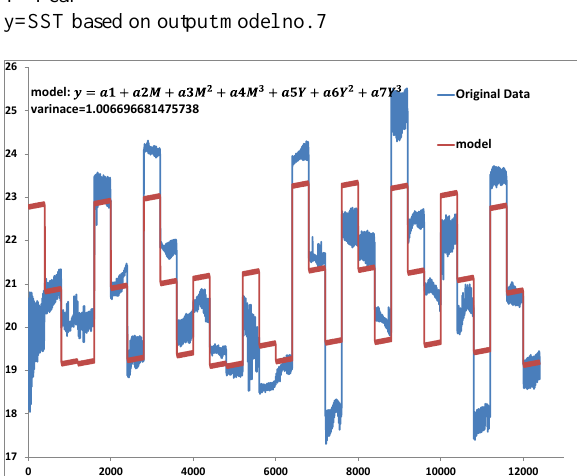
Figure 2. Compare model no. 7 outputs with SST data in MCSST method, where blue line is MCSST data and red line is output model